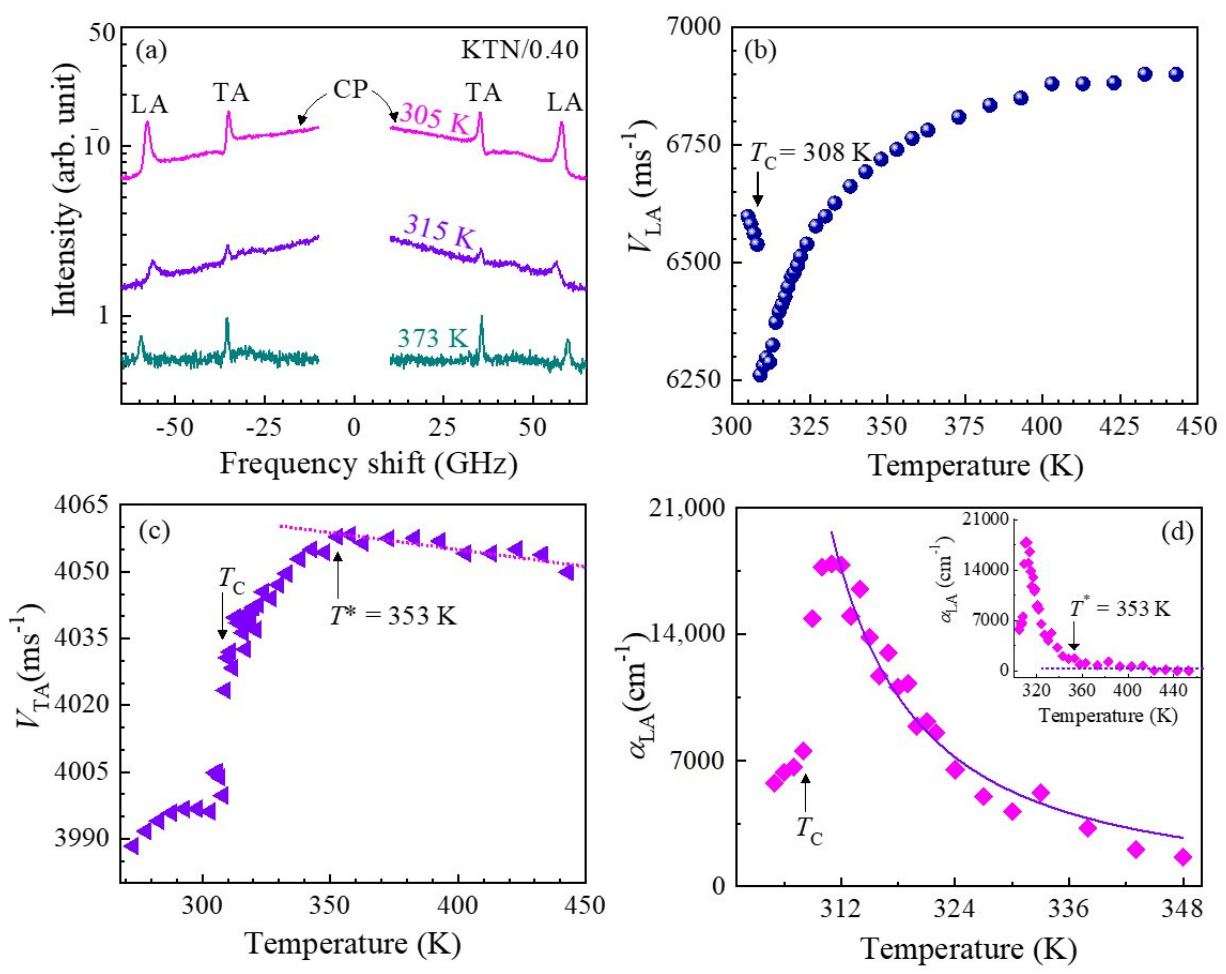
Figure 3. ( a ) The observed Brillouin spectra of non-doped KTN/0.40 single crystal at some selected temperatures measured with FSR = 75 GHz. ( b ) The longitudinal velocity of the LA mode, and ( c ) the transverse velocity of the TA mode in a KTN/0.40 single crystal as a function of temperature. ( d ) The temperature dependence of the longitudinal sound attenuation in a KTN/0.40 single crystal. The short dashed and solid lines in ( c ) and ( d ) are the guide to eyes and the best fit result obtained using Equation (7), respectively. The inset in figure ( d ) exhibits the plot on a large scale to denote the T *. The data were adapted from Refs. [25,58].